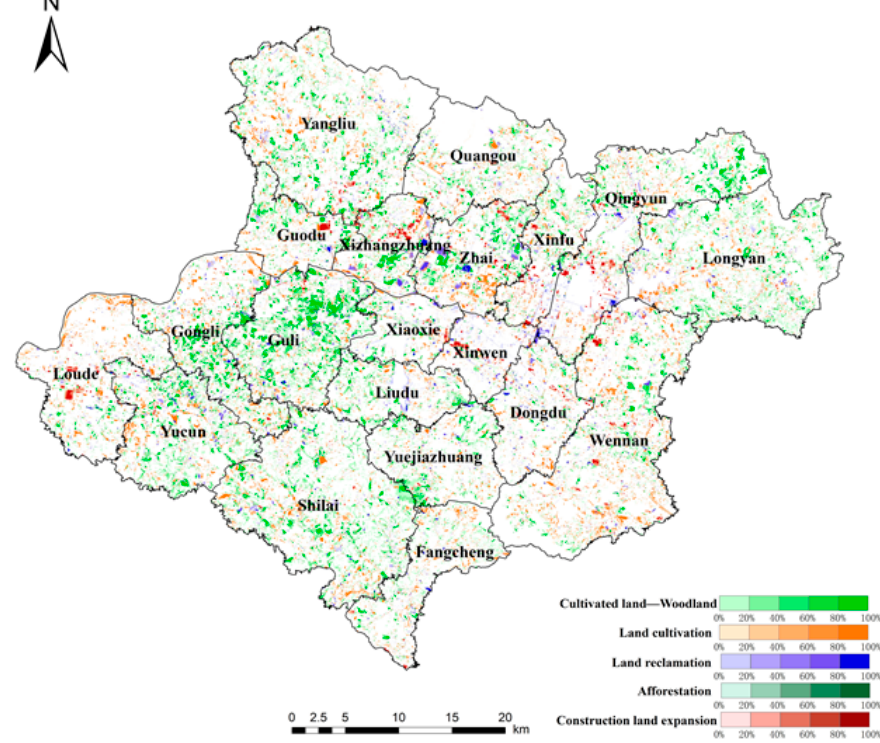
Figure 6. Spatial distribution of the dynamic degree of major land use types in Xintai, 2009–2020.